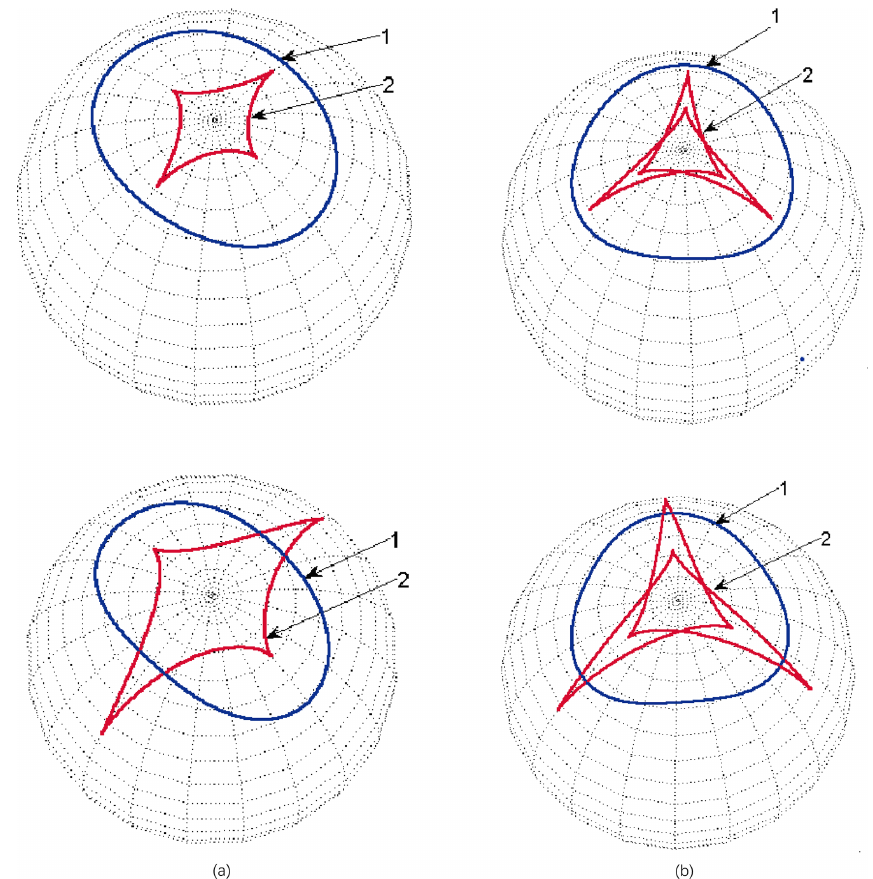
Figure 8. Spherical base curve of pitch curve. (a) n = 2, top: φ = 10 ◦ , λ = 74 ◦ , bottom: φ = 18 ◦ , λ = 74 ◦ . (b) n = 3, top: φ = 5 ◦ , λ = 74 ◦ , bottom: φ = 7 ◦ , λ = 74 ◦ . 1 – Pitch curve. 2 – Spherical base curve of pitch